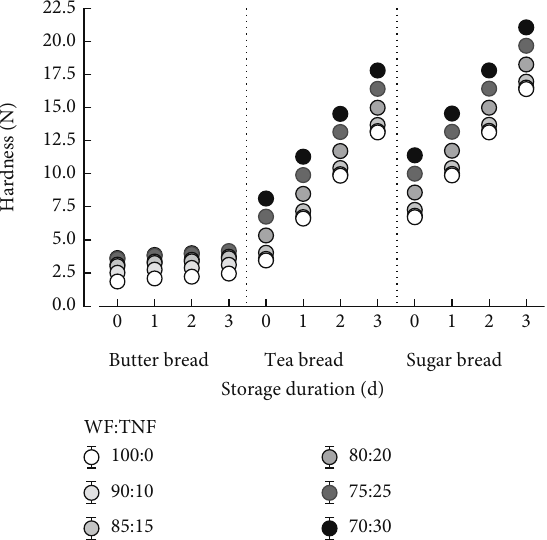
Figure 4: E ff ects of wheat fl our (WF) substitution with tiger nut fl our (TNF) on crumb hardness of butter bread, tea bread, and sugar bread during storage under ambient temperature (28-32 ° C).